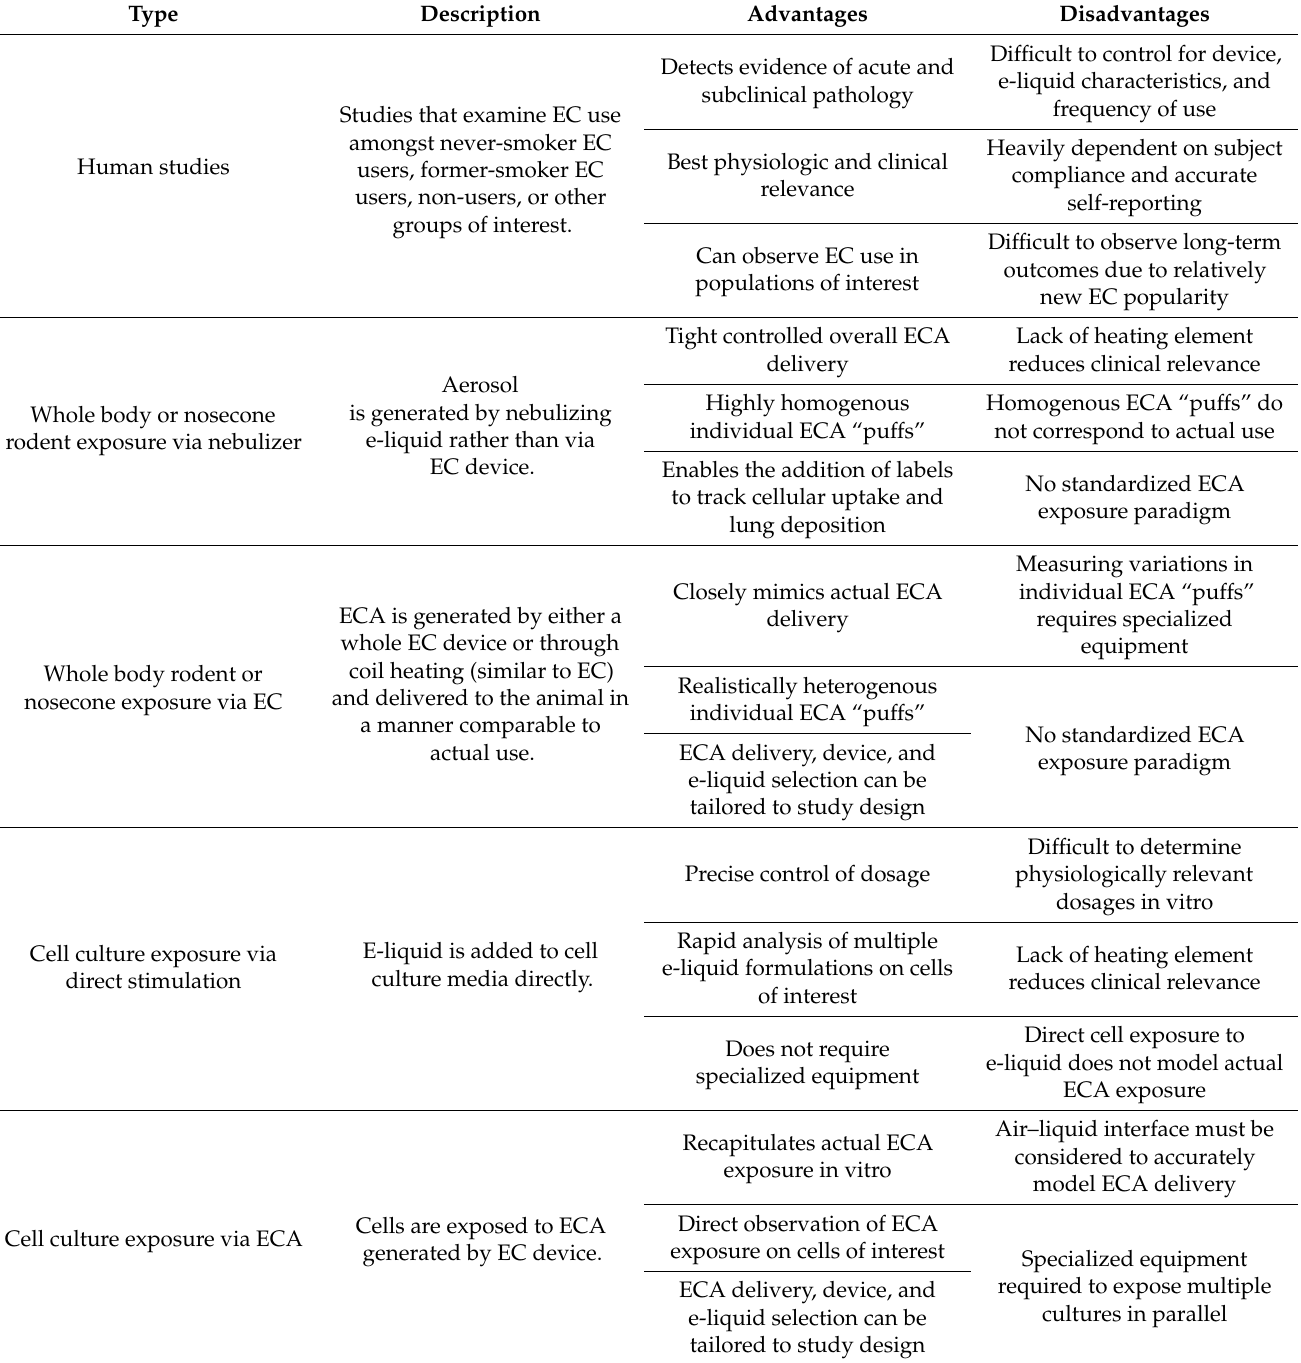
Table 1. Summary of general models to study ECA exposure and their advantages and